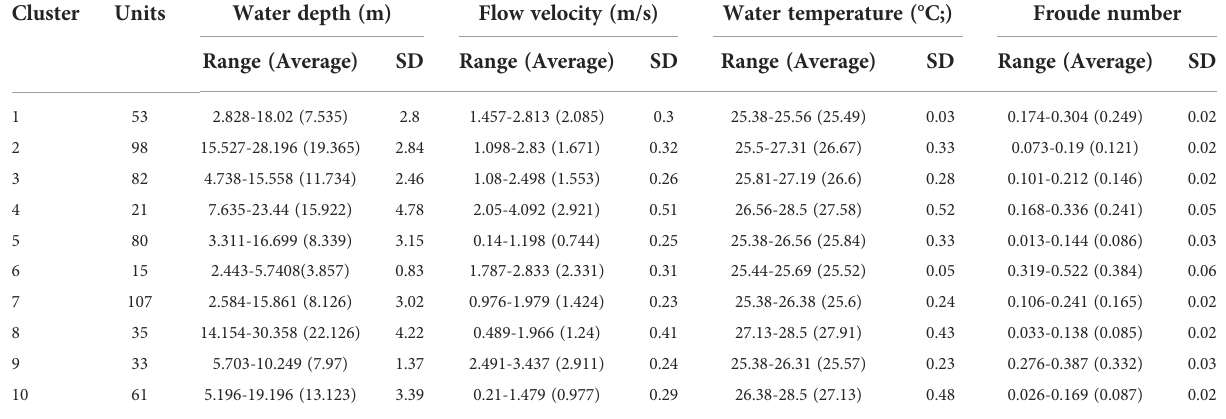
TABLE 3 Statistical characteristics of hydrologic and hydrodynamic quantities in each cluster.